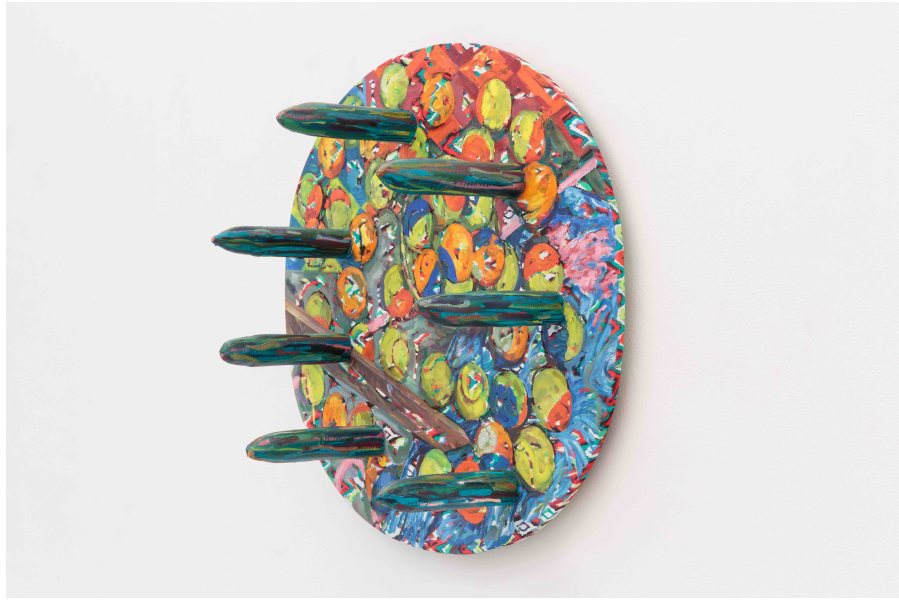
Figure 6: Dan Howard-Birt, Ship of Fools (Robert MacBryde), 2016, Oil on printed fabric and wood 68cm